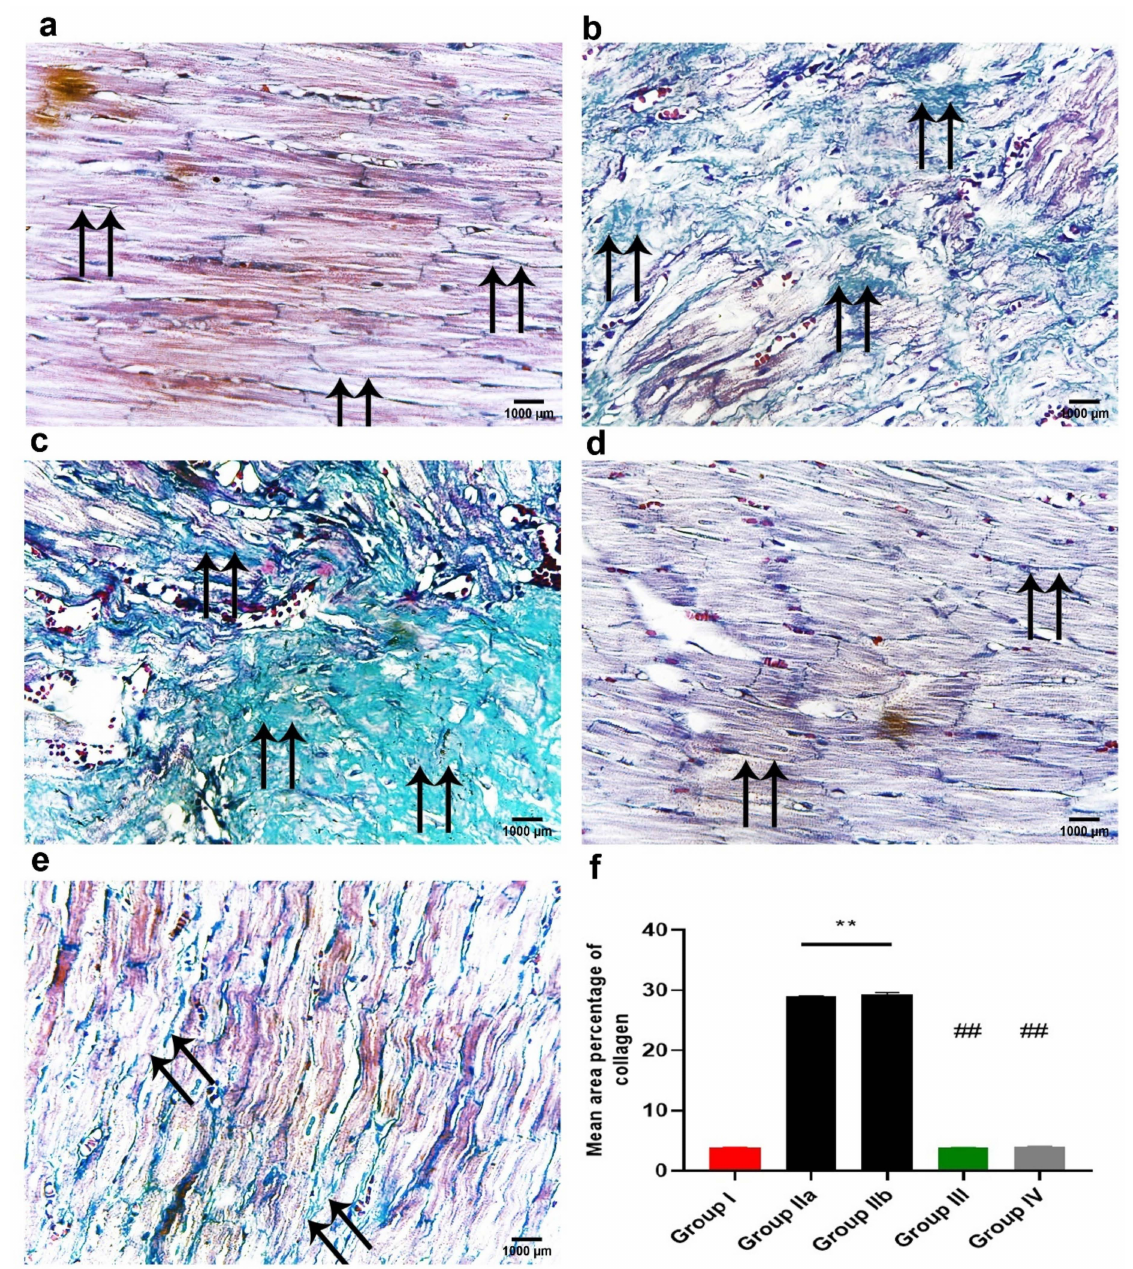
Figure 11. Representative photomicrographs of Masson’s trichrome-stained sections from the left ventricle of the myocardium in the different experimental groups: ( a ) Group I (control group) showed minimal collagen fibers between cardiac muscle fibers (double arrow); ( b ) Group IIa (DOX/Trz group) showed moderate collagen fiber deposition among cardiac muscle fibers (double arrow); ( c ) Group IIb (recovery group) showed marked collagen fiber accumulation between cardiac muscle fibers (double arrow); ( d ) Group III (prophylactic group) showed minimal collagen fiber deposition among cardiac muscle fibers (double arrow); ( e ) Group IV (curative group) showed few collagen fibers among cardiac muscle fibers (double arrow); and ( f ) Histogram representing the mean area percentage of collagen fibers in all experimental groups. **, significant compared to Group I at p < 0.01; ##, significant compared to Group II at p < 0.01; n =